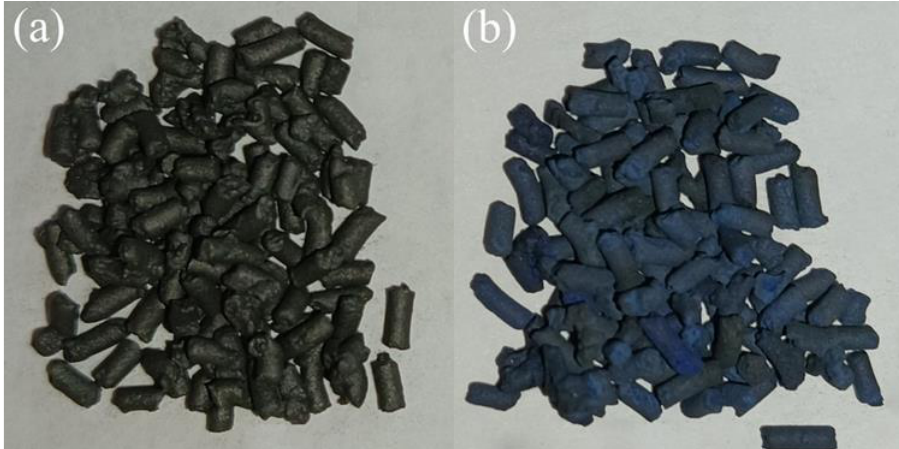
Figure 1. Color change of the catalyst as a result of consecutive thermal treatments described in the text: ( a ) — S2 catalyst; ( b ) — B catalyst.